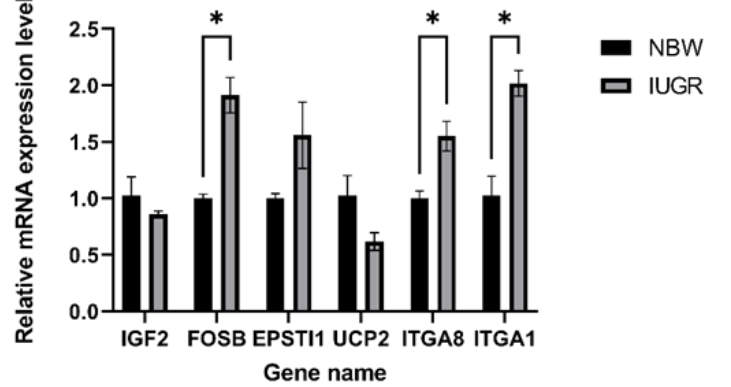
Figure 5. Validation of 6 DEGs between the NBW and IUGR piglet pituitary by RT-qPCR. The black columns indicate the NBW results; the gray columns indicate the IUGR results. The x -axis represents the names of the DEGs, and the y -axis represents the log2 fold-change from RT-qPCR. “*” indicates p < 0.05.